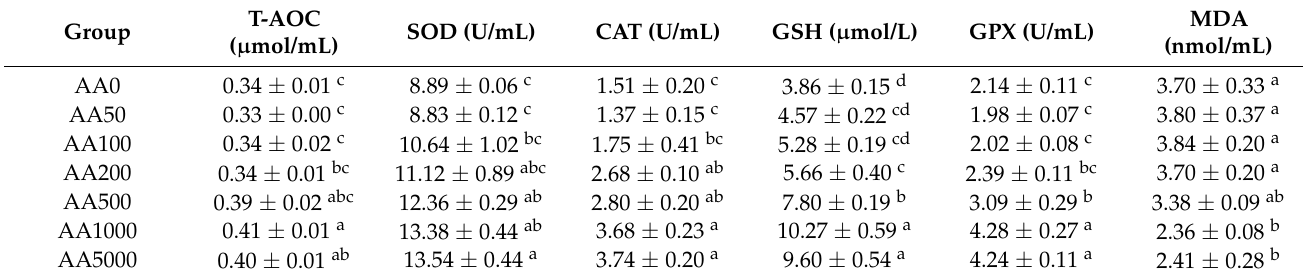
Table 5. Effects of dietary ascorbic acid on the anti-oxidative capacity in the cell-free hemolymph of abalone ( Haliotis discus hannai ) after a 100-day feeding trial.